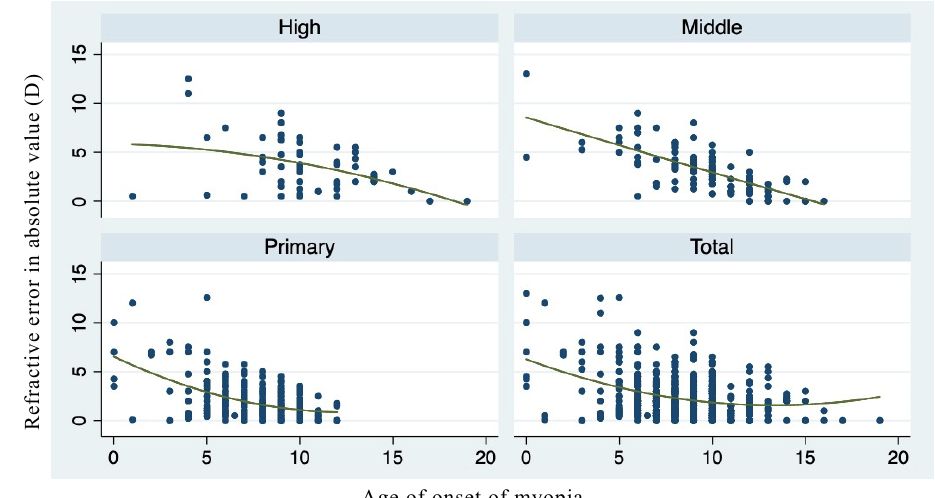
Figure 1. Age of onset of myopia and current myopia severity of the schoolchildren.